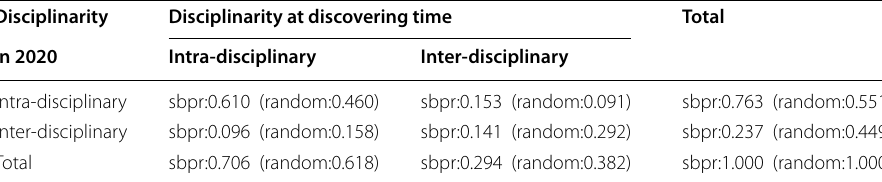
Table 6 Distribution of the sleeping beauty—Prince Pairs Disciplinarity Disciplinarity at discovering